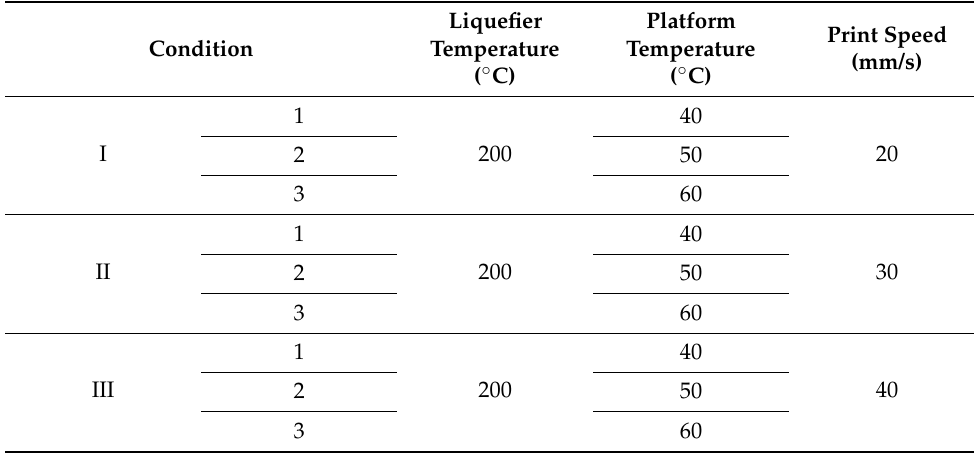
Table 3. Various conditions of printing.